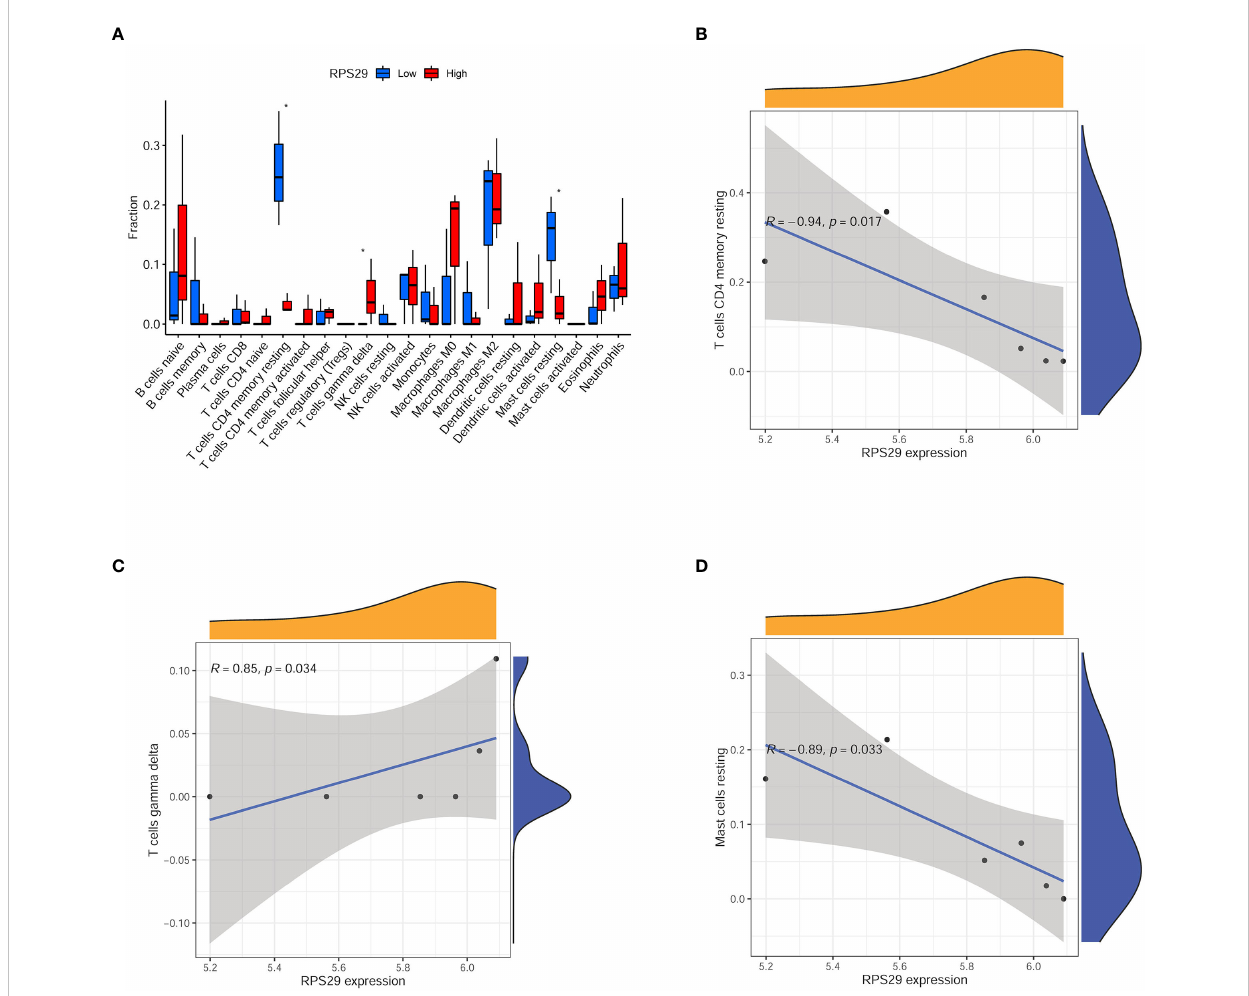
FIGURE 6 Immune in fi ltration analysis according to RPS29 expression in the brain of Covid-19 patients. (A) immune cell fraction between low and high expression of RPS29 in the brain of Covid-19 patients. (B) the correlation between RPS29 expression and T cells CD4 memory resting. (C) the correlation between RPS29 expression and T cells gamma delta. (D) the correlation between RPS29 expression and mast cells resting. *p <